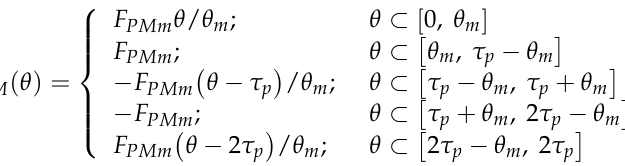
Figure 3. Schematic diagrams of magnetomotive force (MMF) models with SPM and IPMR. The MMF can be expressed by a piecewise function as: